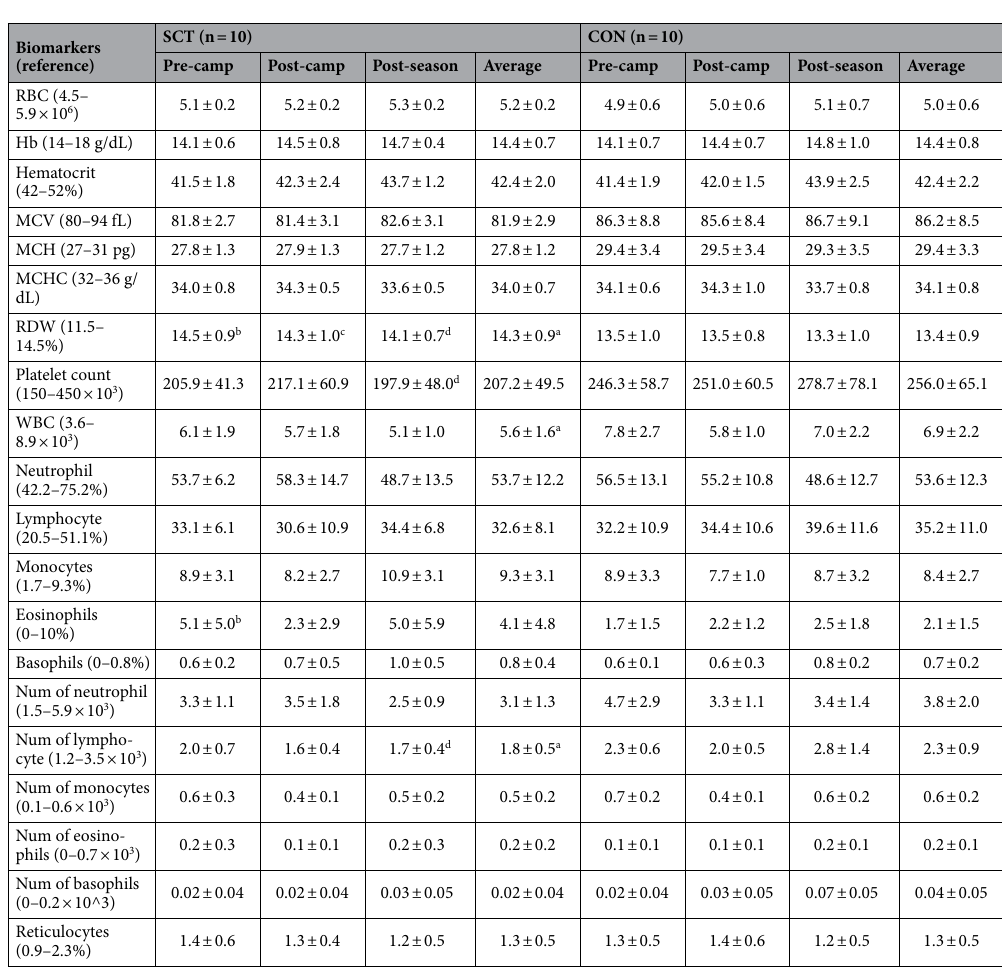
Table 2. The Completed Blood Count file of two groups (SCT vs. CON) across the entire football season (pre-camp, post-camp, and post-season). Data presented as mean ± SD. SCT sickle cell trait, RBC red blood cells, Hb hemoglobin, MCV corpuscular volume, MCH corpuscular volume, MCHC corpuscular hemoglobin concentration, RDW red cell distribution width, WBC white blood cell count. a Significant difference in SCT compared to CON. b Significant difference in SCT compared to CON at pre-camp. c Significant differences in SCT compared to CON at pre-season/post-camp. d Significant difference in SCT compared to CON at post- season.